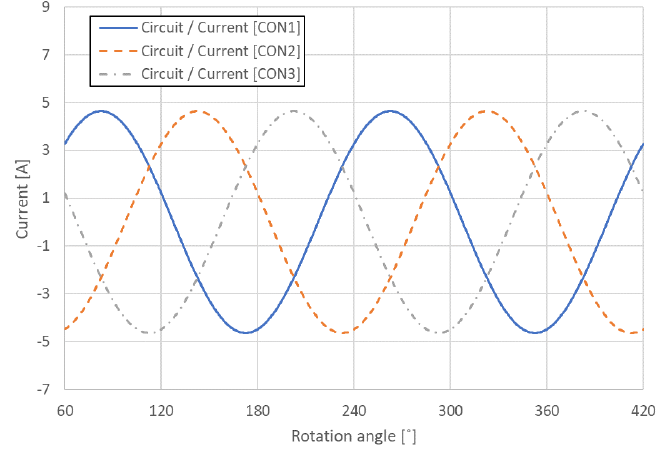
Figure 4. Current condition.